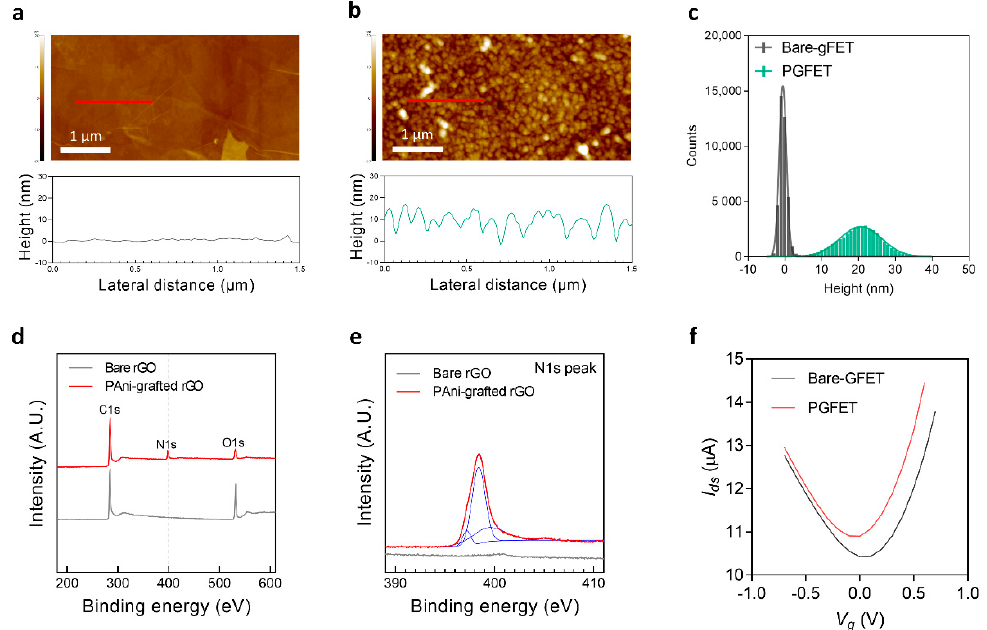
Figure 2. Surface characterization of the bare − gFET and PGFET. The AFM images of the bare − gFET ( a ) and PGFET ( b ) and their corresponding height profiles. ( c ) The height distributions of the bare − gFET and PGFET in a 1 × 1 μ m 2 area. ( d ) XPS analysis of the bare rGO and PAni − grafted rGO. ( e ) High − resolution N 1s XPS spectrum of the bare rGO and PAni − grafted rGO. ( f ) I ds vs. V g curves for a bare − gFET and PGFET.